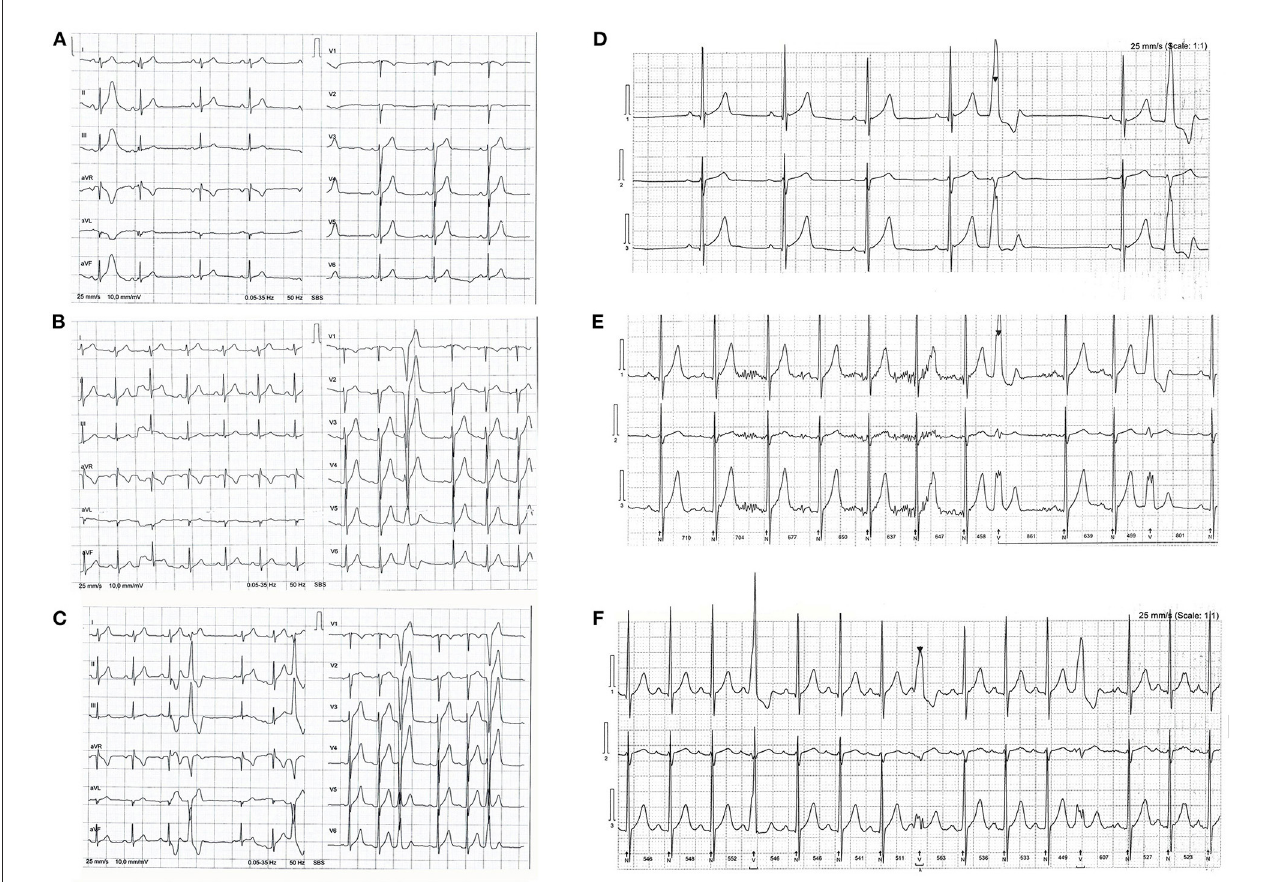
FIGURE2 (A) Shows a baseline electrocardiogram (ECG). Sinus rhythm and one ectopic premature atrial beat. (B) Shows an ECG after P1, phase one (rapid weight loss & high intensity training); sinus rhythm and one ectopic premature ventricular beat (PVB). (C) Shows an P2, phase two (high intensity training) ECG with sinus rhythm and PVB in trigeminy. Three lead ECG Holter monitoring after P1 shows ectopic PVB in bigeminy in (D) and trigeminy in (E) , frequent ectopic PVB after P2 in (F)